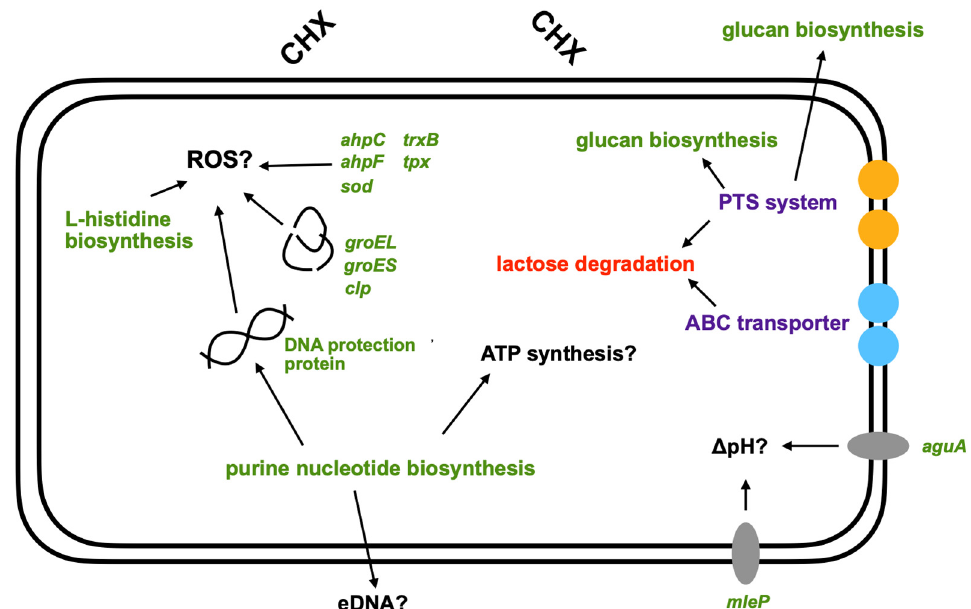
Figure 3. Schematic representation of a possible stress response in S. mutans to CHX treatment found in this study. Shown are the mechanisms described in the discussion in response to CHX treatment.